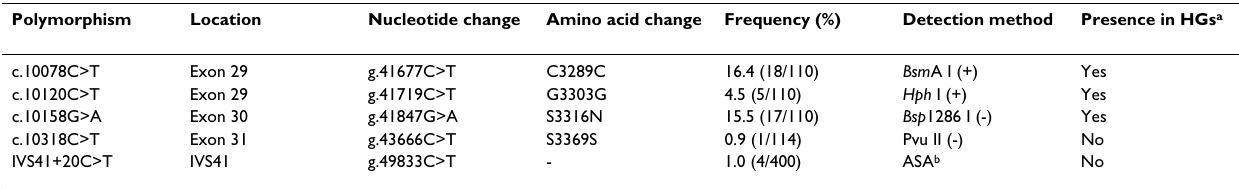
Table 4: PKD1 polymorphisms detected in Thai population